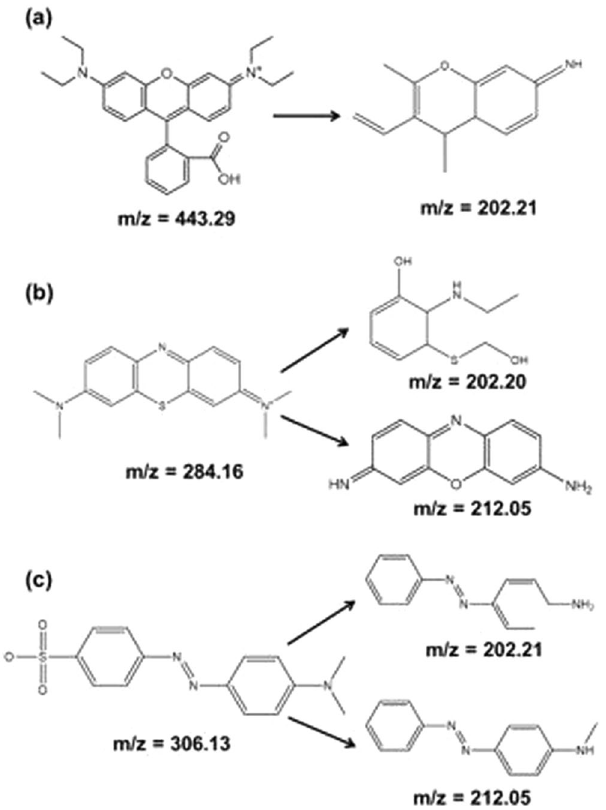
Figure 13. Probable degraded products for ( a ) RhB, ( b ) MB and ( c ) MO after exposer of 120